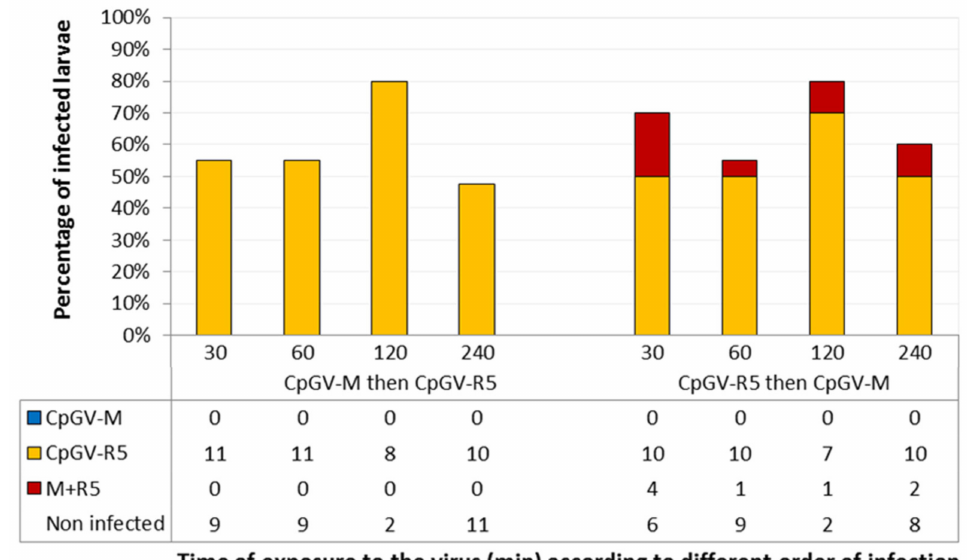
Figure 1. Infection status determined by quantitative polymerase chain reaction (qPCR) of R GV larvae ( n ≈ 150) inoculated sequentially with both viruses for the durations indicated. Three experiments were carried out. The cumulative numbers of larvae infected by CpGV-M or CpGV-R5 or both CpGV-M and CpGV-R5 (labelled M + R5) are shown in the